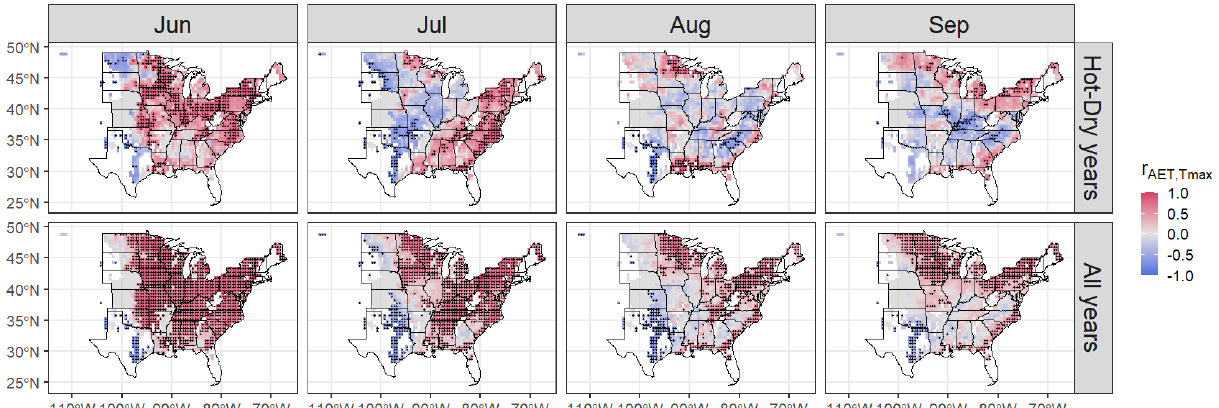
Figure A6. Interannual correlation between actual evapotranspiration and maximum temperature for a given month of the year conditioned on hot–dry events and repeated for the period from June to September. Dots indicate statistical significance at the 95% confidence